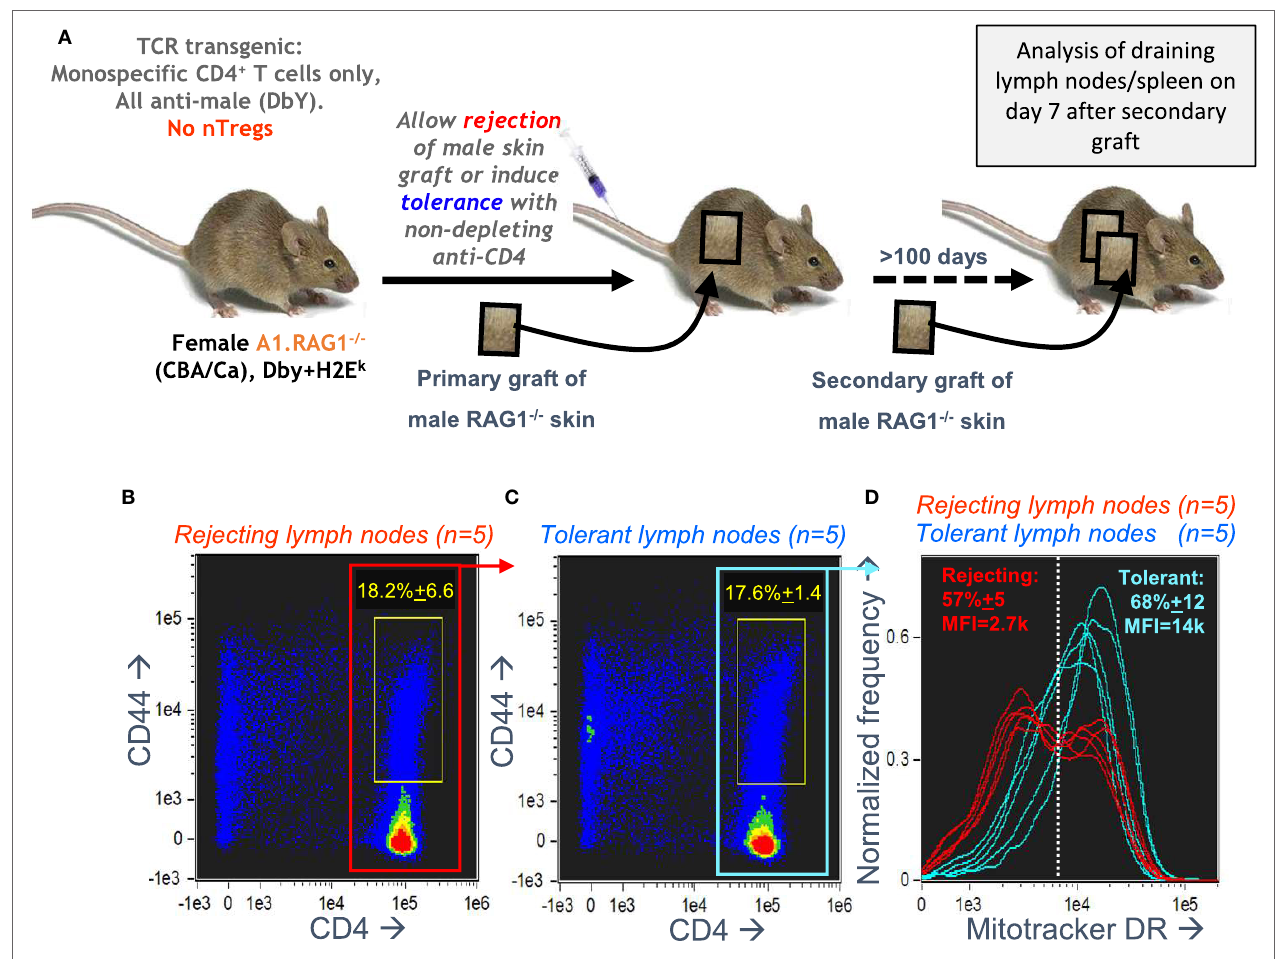
FigUre 4 | Antigen-specific CD4 + T cells undergoing a secondary graft rejection response have a bimodal distribution of mitochondria. (a) Schematic of the in vivo model used to compare secondary memory responses of antigen-specific CD4 + T cells to a challenge skin graft after rejection or induction of tolerance. (b–D) Draining lymph nodes were taken, 7 days after a secondary challenge with male skin, from female A1RAG mice that had been either been allowed to reject a male skin graft or had been made tolerant by anti-CD4 treatment (5 mice per group). Cells from each mouse were individually stained with Mitotracker DR, CD4-PE-CF594, CD44-APC-eflour780, and 7AAD and 20,000 images were acquired by ImageStream for each sample. Singlet, viable cell images were gated on 7AAD intensity (2N DNA) and high aspect ratio, bright field area, and low contrast. All rejecting (a) and tolerant (b) gated images are pooled and shown in the plots, and the percentage (mean ± SD) of activated CD4 + CD44 + T cells (within yellow gates) are indicated. The Mitotracker DR intensity of individual rejecting and tolerant CD4 + gated cells [red (b) and blue (c) boxes] is plotted in (D)